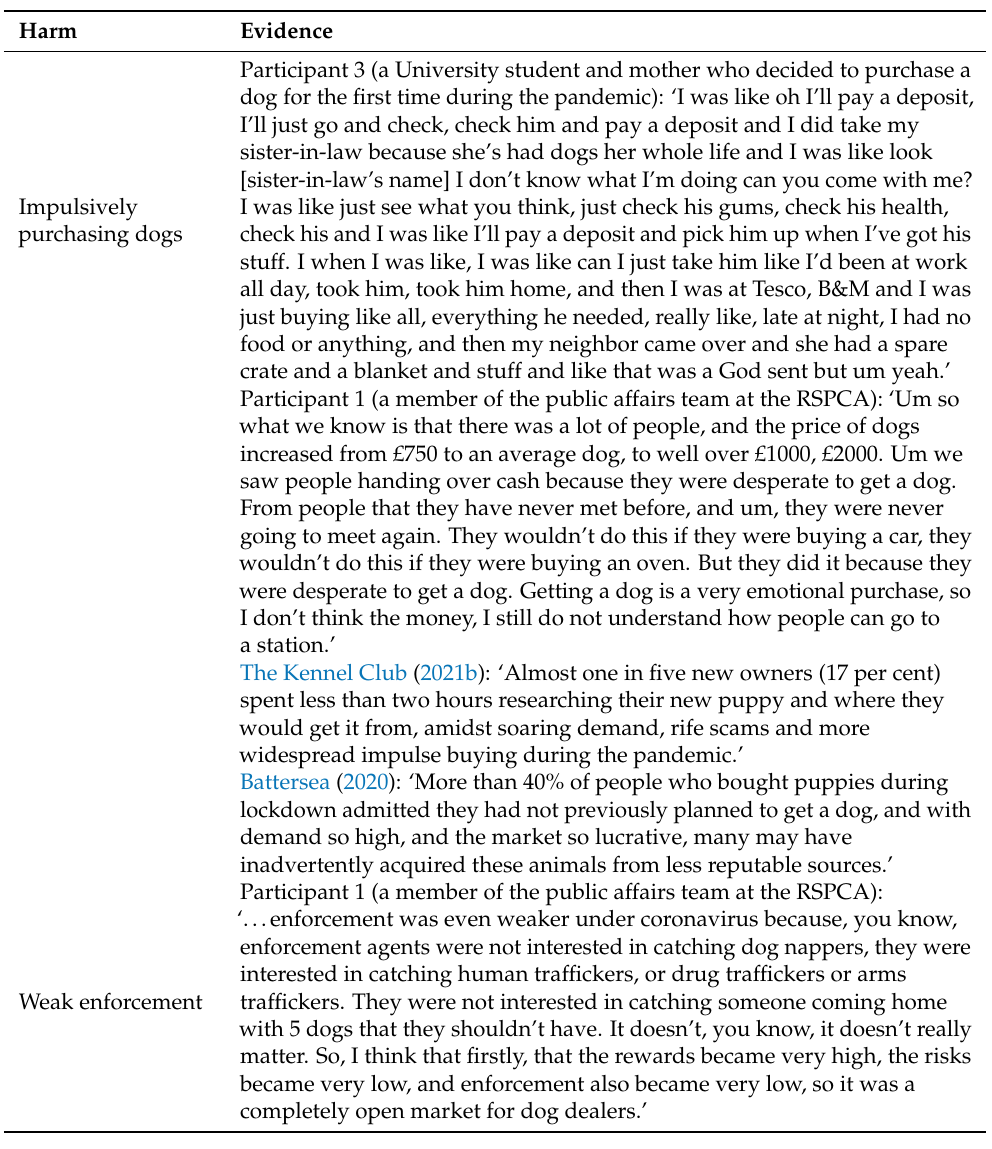
Table 1. Overview of research data detailing the harm suffered by dogs during the coronavirus pandemic (in terms of their physical, behavioral, and psychological